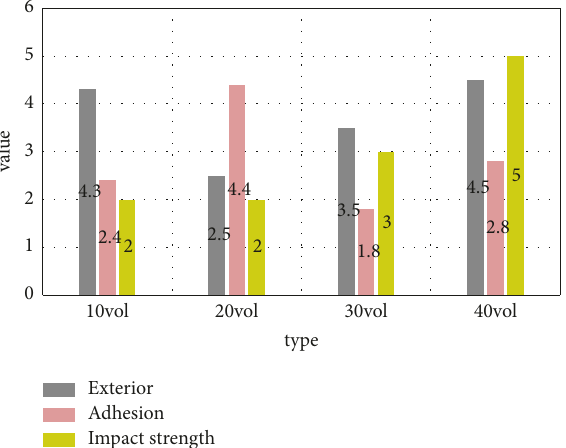
Figure 7: Effect of crosslinker amount on coating